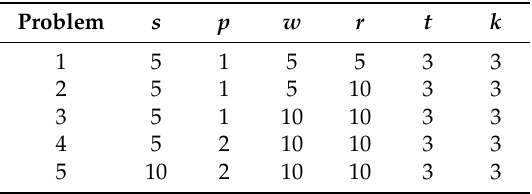
Table 3. Characteristics of test